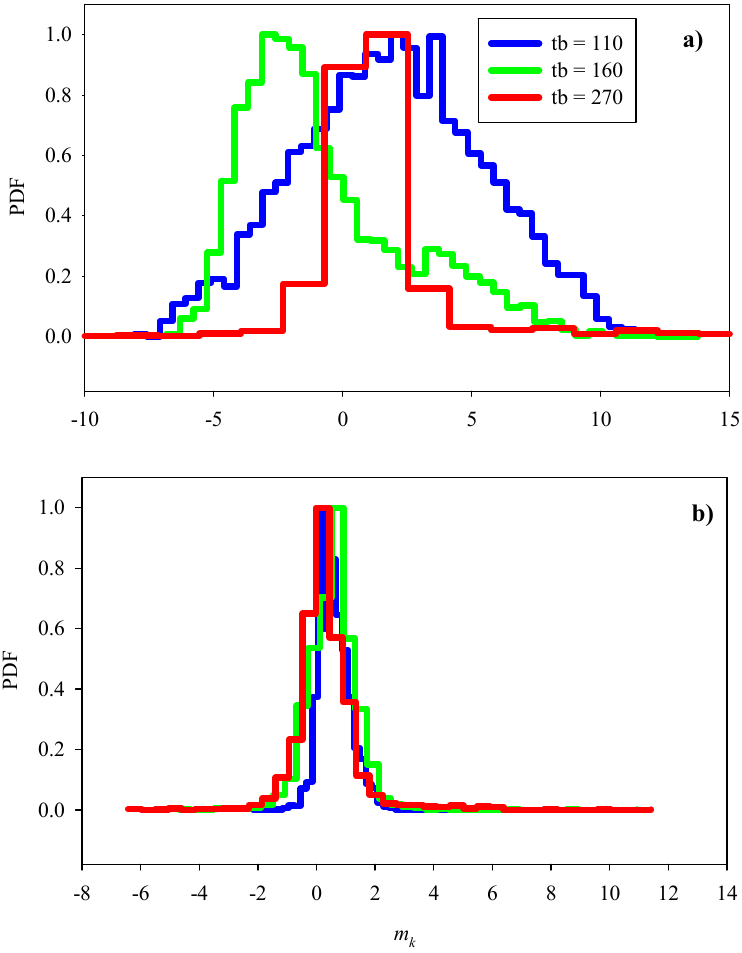
Figure 8. The normalized probability distribution function of m k . ( a ) on-axis, ( b ) off-axis. tb is the time bin.